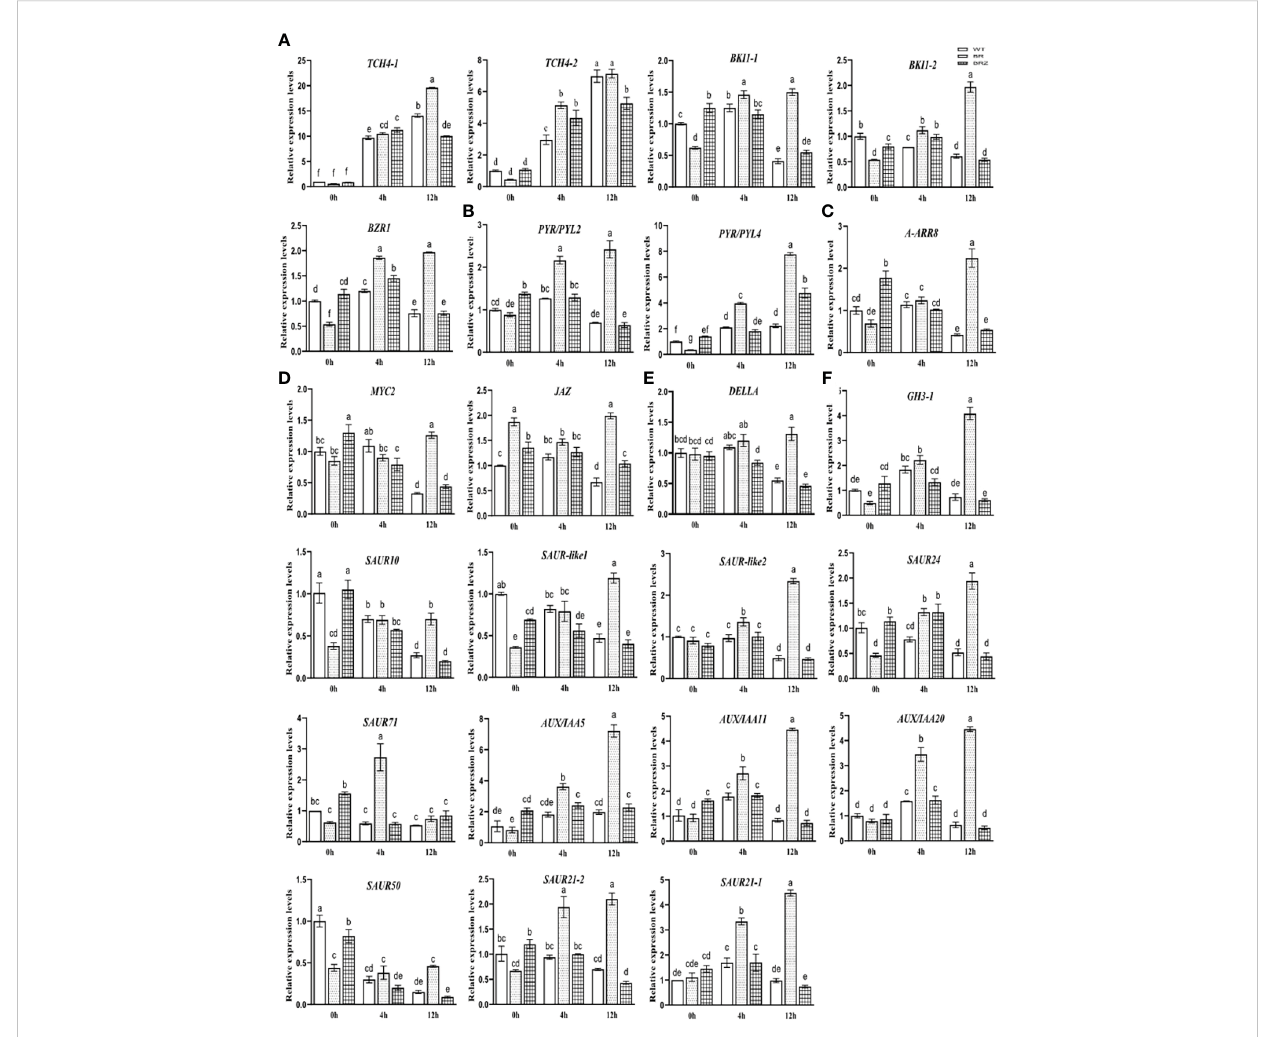
FIGURE 7 The expression of hormone signaling pathway genes, BR (A) , ABA (B) , CK (C) , GA (D) , IAA (E) , and JA (F) , regulated by EBR under cold stress. Data are mean ± SE ( n = 3, biological replicates). The different letters were signi fi cantly different in Tukey ’ s test ( p <